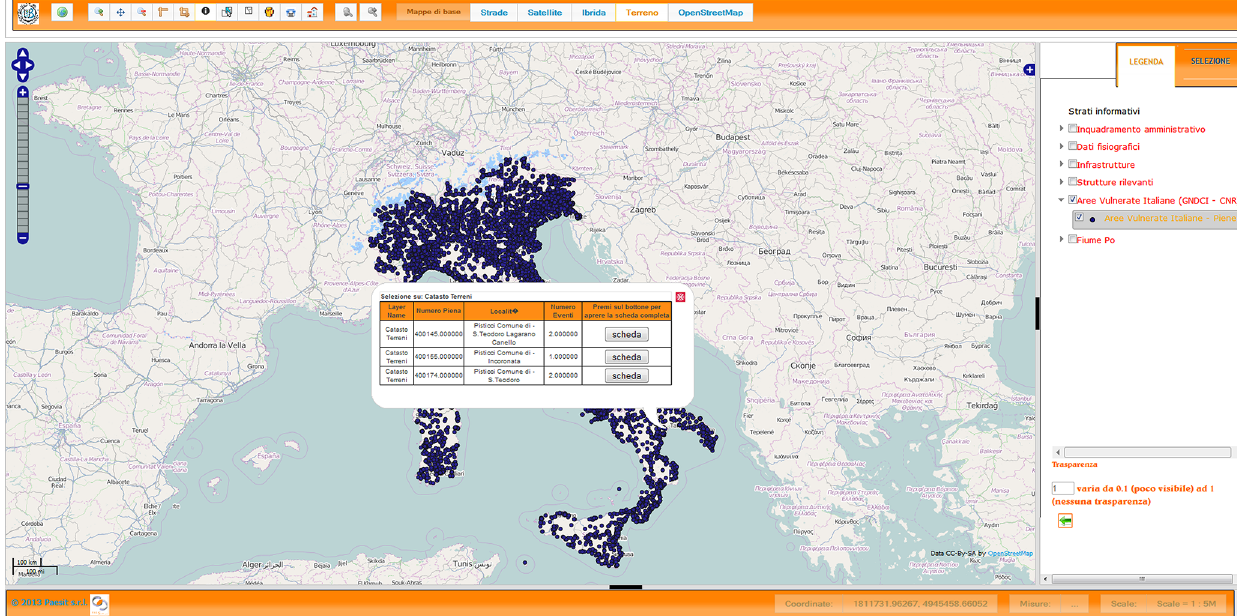
Figure 11. Search for the location of historical events that occurred in this area of Italy. Source: AVI project (2000).